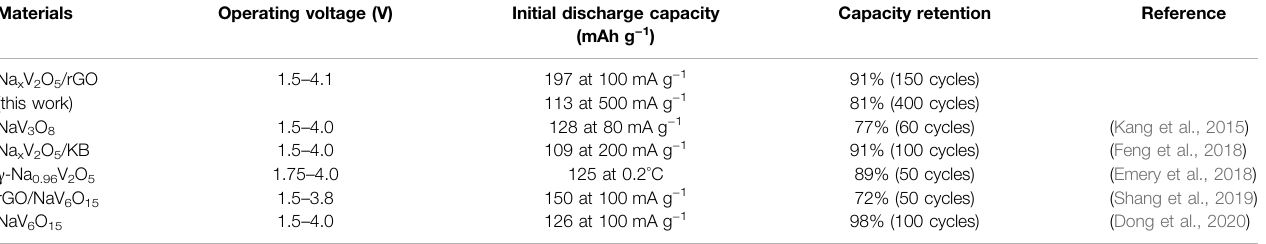
TABLE 1 | Comparison of the electrochemical performance of the electrode materials between this work and previous reports. Materials